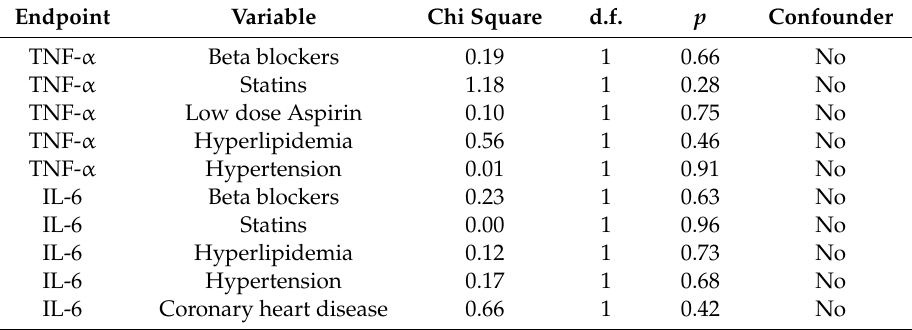
Table 2. Mantel-Haenszel analysis of potential confounding